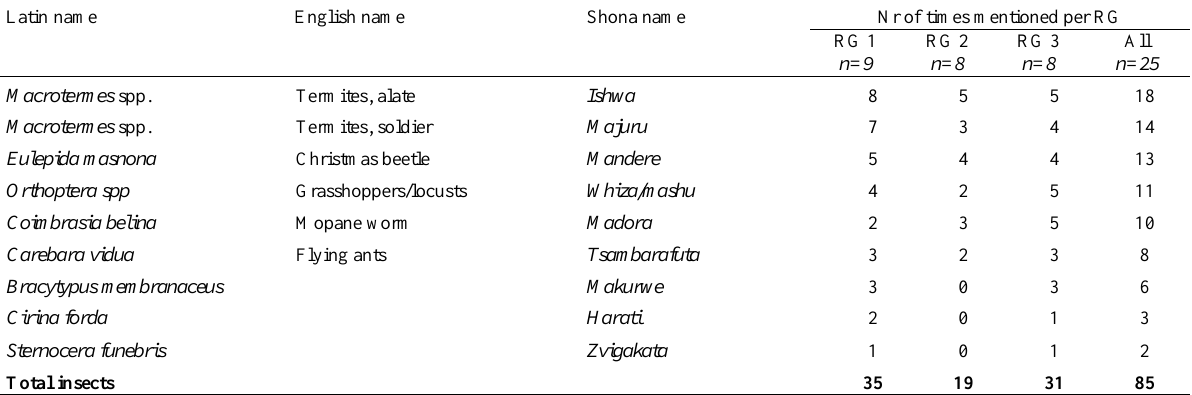
Table A3.6: Insects, species names and collection scores.